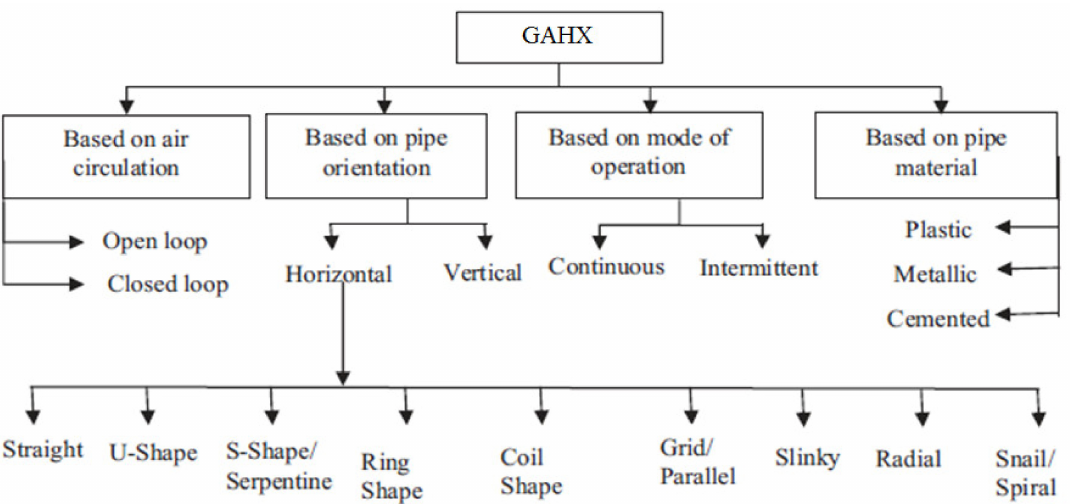
Figure 1. Classification of